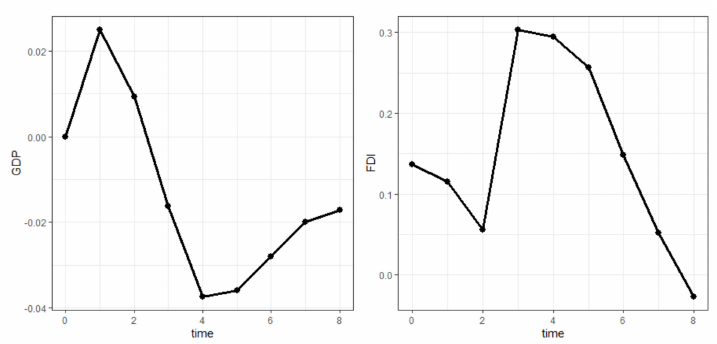
Figure 4. Orthogonalized impulse response GDP on FDI and FDI on